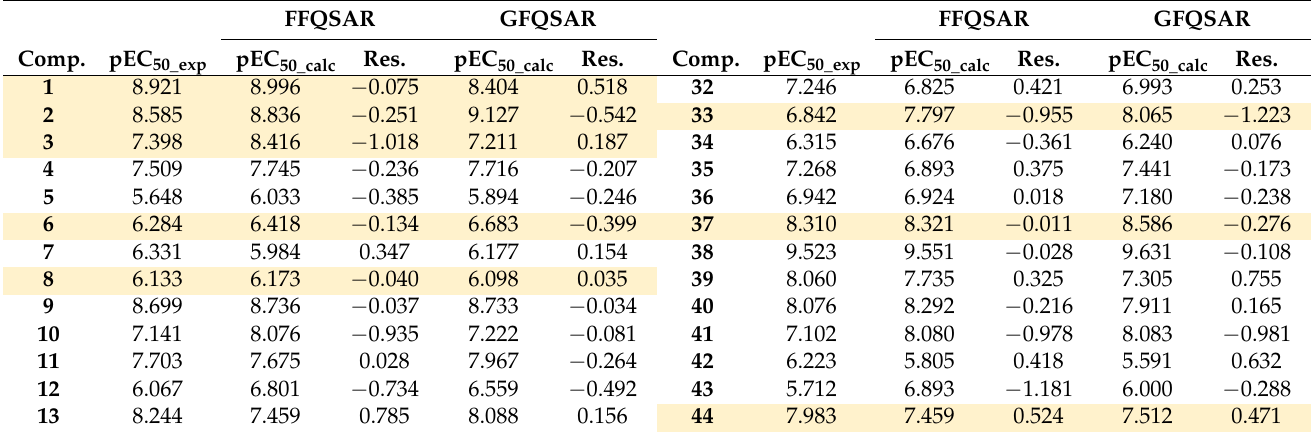
Table 3. Experimental and calculated pEC 50 and residual values for the analyzed compounds obtained with the force-field QSAR (FFQSAR) and Gaussian-field QSAR (GFQSAR) model. The highlighted rows show the test set compounds. FFQSAR GFQSAR FFQSAR